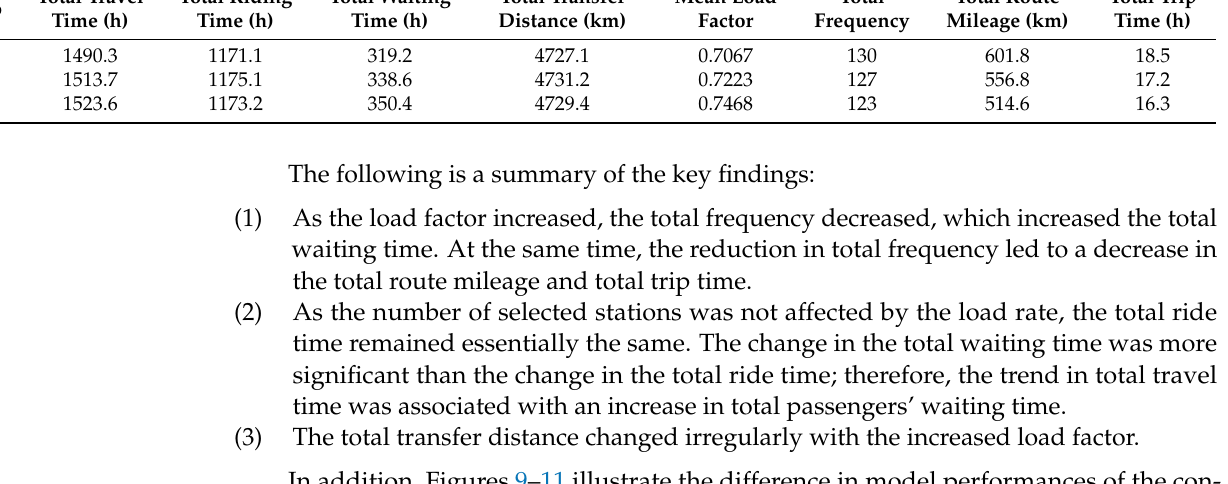
Figure 10. Comparative analysis of the conventional and proposed models for various station ca ‐ pacities.